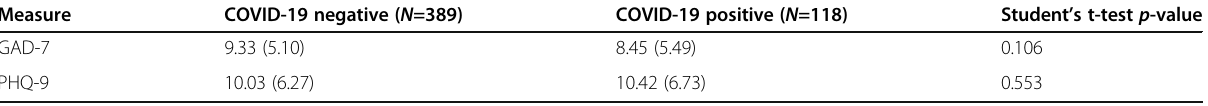
Table 3 Statistical comparisons between GAD-7 and PHQ-9 among COVID-19 positive and COVID-19 negative